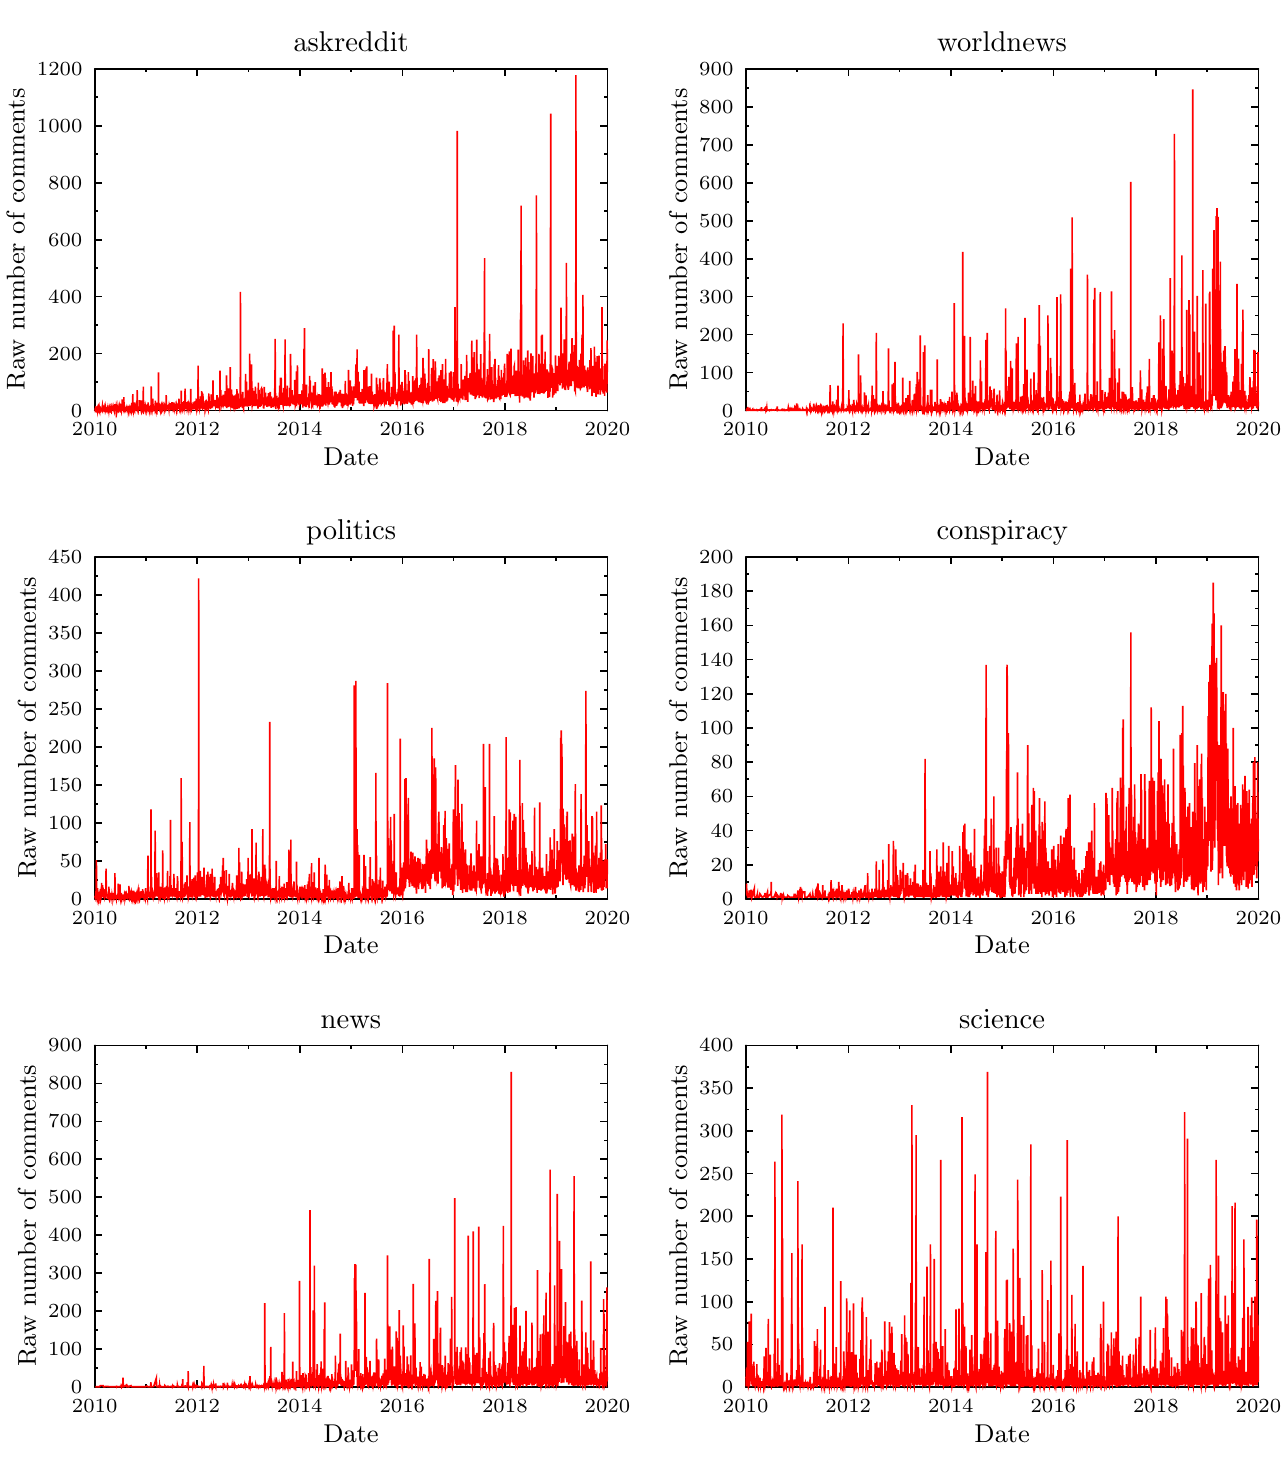
Figure 4. Daily number of new user comments containing vaccination keywords for the six subreddits: subreddits: askreddit, politics, news, worldnews, consipracy, and science